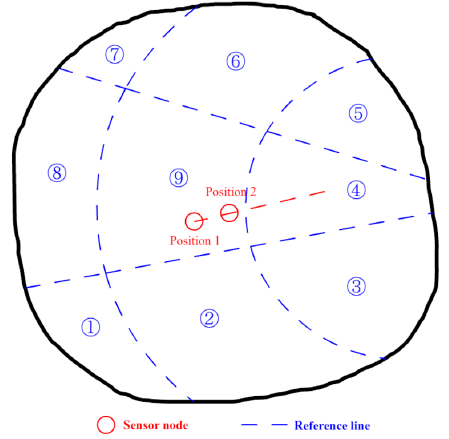
Figure 5. Illustration of the principle of node movement.